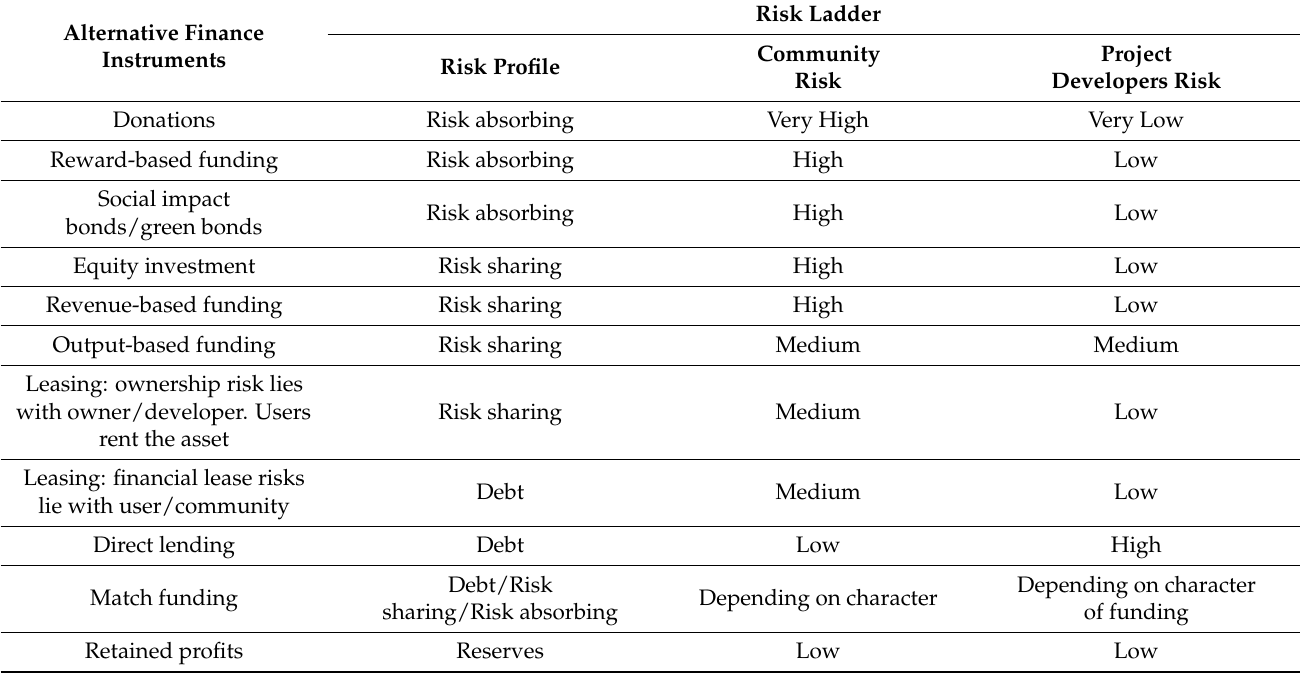
Table 1. Alternative finance instrument risks for community and project